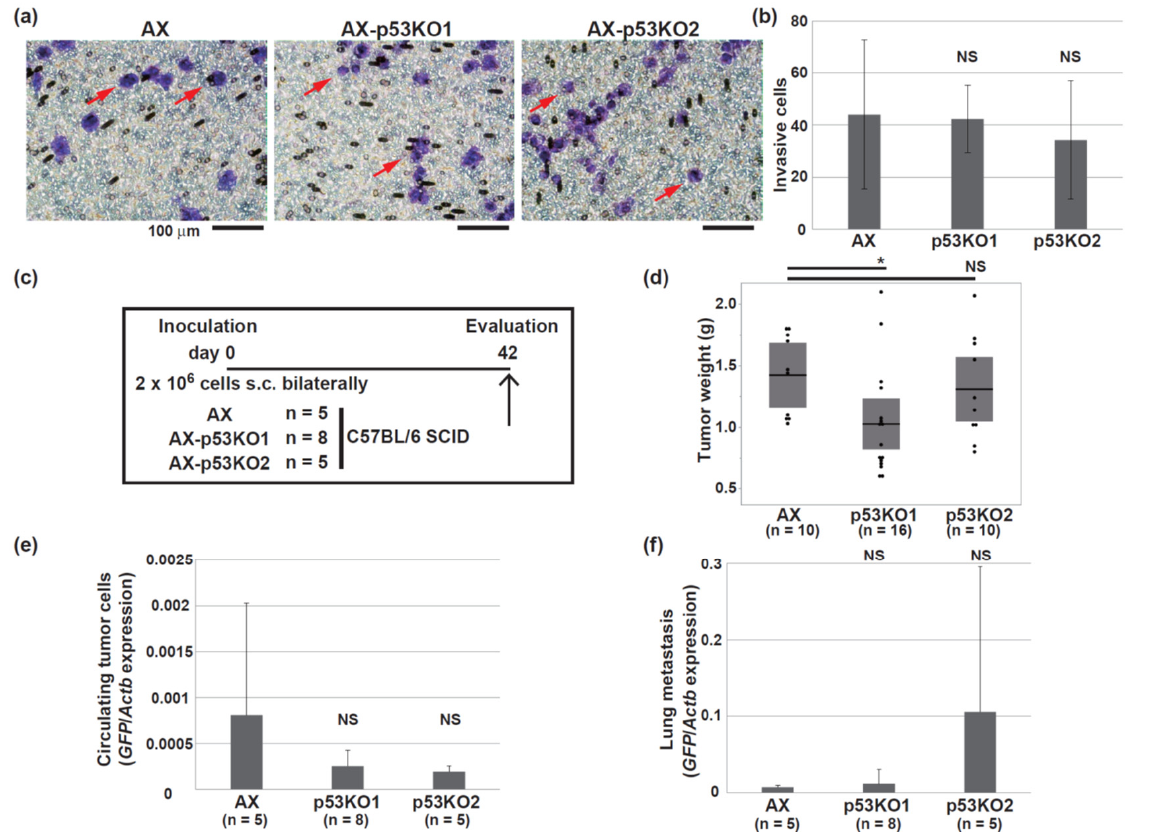
Figure 3. Knockout of wild-type and mutant p53 in AX cells did not prevent tumor progression. ( a , b ) Microscope images of the invasion assay using the AX and p53-knockout AX cells. Represen- tative purple-stained cells are indicated with arrows. The mean number of invasive cells counted in three different fields of each transwell in triplicate experiments is shown in ( b ). ( c ) The schedule of cell inoculation into C57BL/6 SCID mice. ( d ) The dot plot of weight of primary tumors. The horizontal bars and boxed regions show the means and the 95% confidence intervals, respectively. ( e , f ) RT and real-time PCR analysis of GFP mRNA in whole blood ( e ) or a lung ( f ) derived from mice inoculated with the indicated cells. (* p < 0.05; NS, not